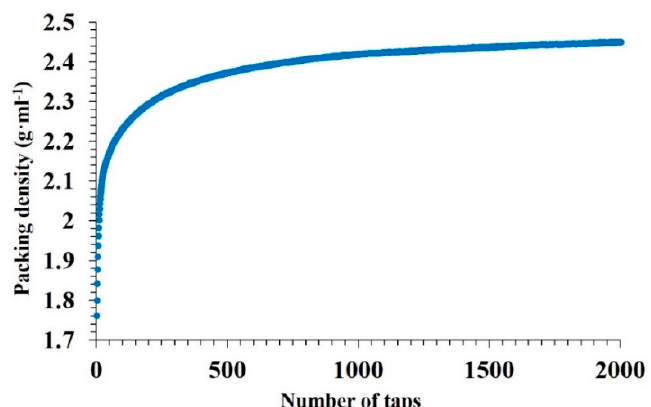
Figure 2. Average packing density of the MoSi 2 -30 wt.% AlSi10Mg powder as a function of stress.